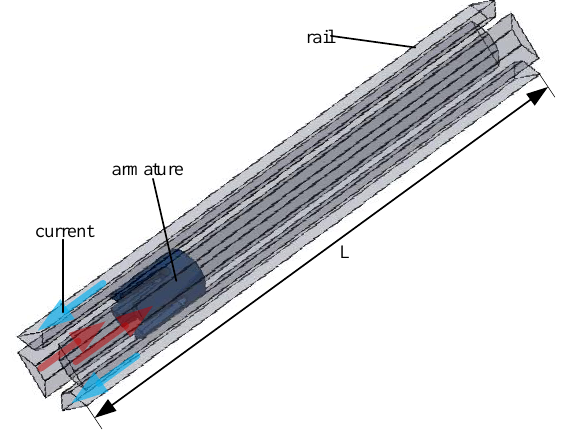
FIGURE 1. Four-rail electromagnetic launcher model